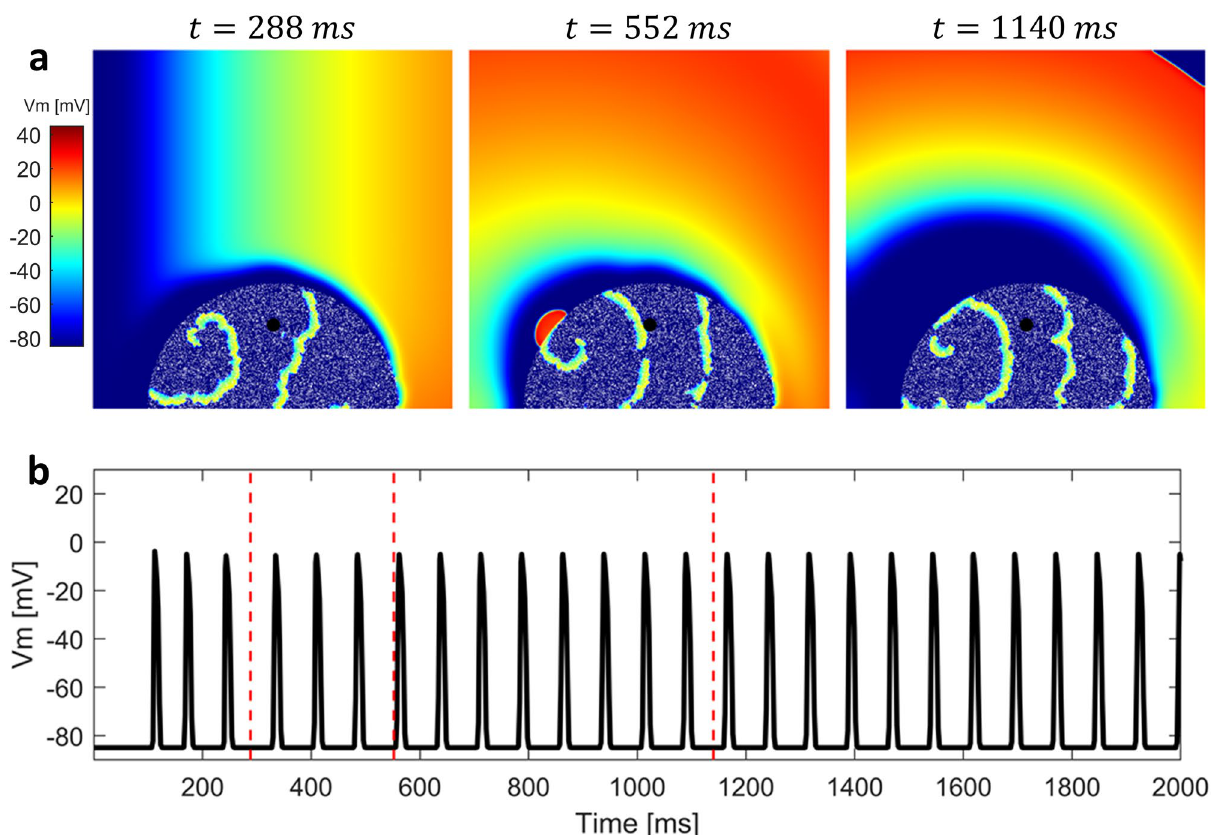
Figure 6. Generation of a lost dome spiral wave in the BrS region reproduced with the 2D model. ( a ) Sequence 0 of snapshots taken from the 10 × 10 cm tissue model. The value of d w was 0.3, whereas the radius of the BrS region was 3.5 cm. Percentage of fibrotic tissue was set to 20% . A quasi stable spiral wave is observed in the BrS region, and repeatedly stimulates the healthy tissue. ( b ) Membrane potential in the BrS region recorded in the point indicated by a black dot in the snapshots. Both orthodromic and antidromic P2R occur at the interface between healthy and BrS regions. When diastolic interval is particularly low and/or electrotonic current is particularly high, AP is not able to recover the dome. Due to the formation of a quasi stable spiral wave, AP is highly regular. Red dashed lines indicate the time instants at which snapshots were